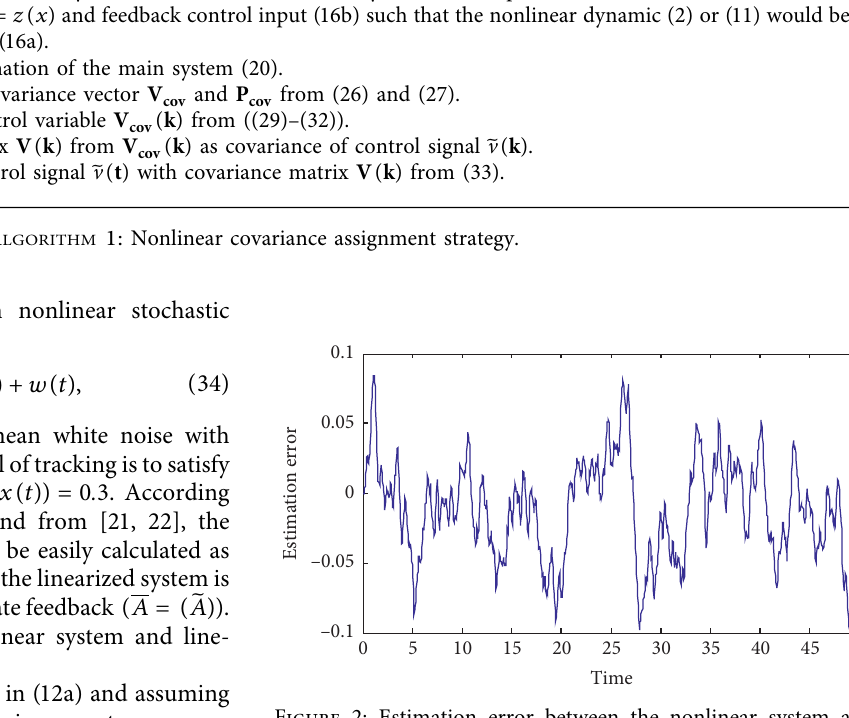
Figure 2: Estimation error between the nonlinear system and linearized system.